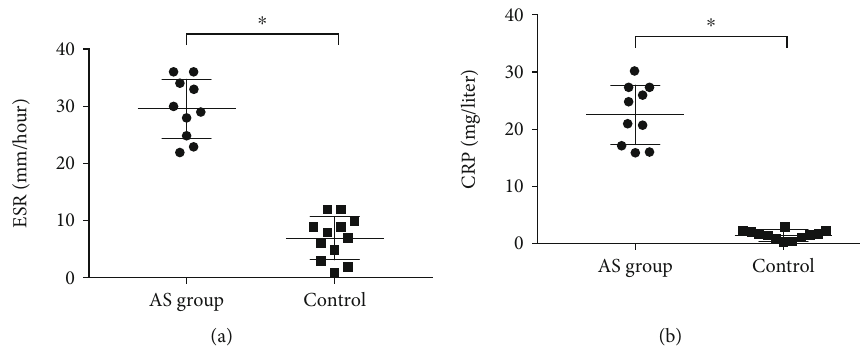
Figure 1: The ESR and CRP levels in the AS and control groups. ∗ P < 0 : 05 .